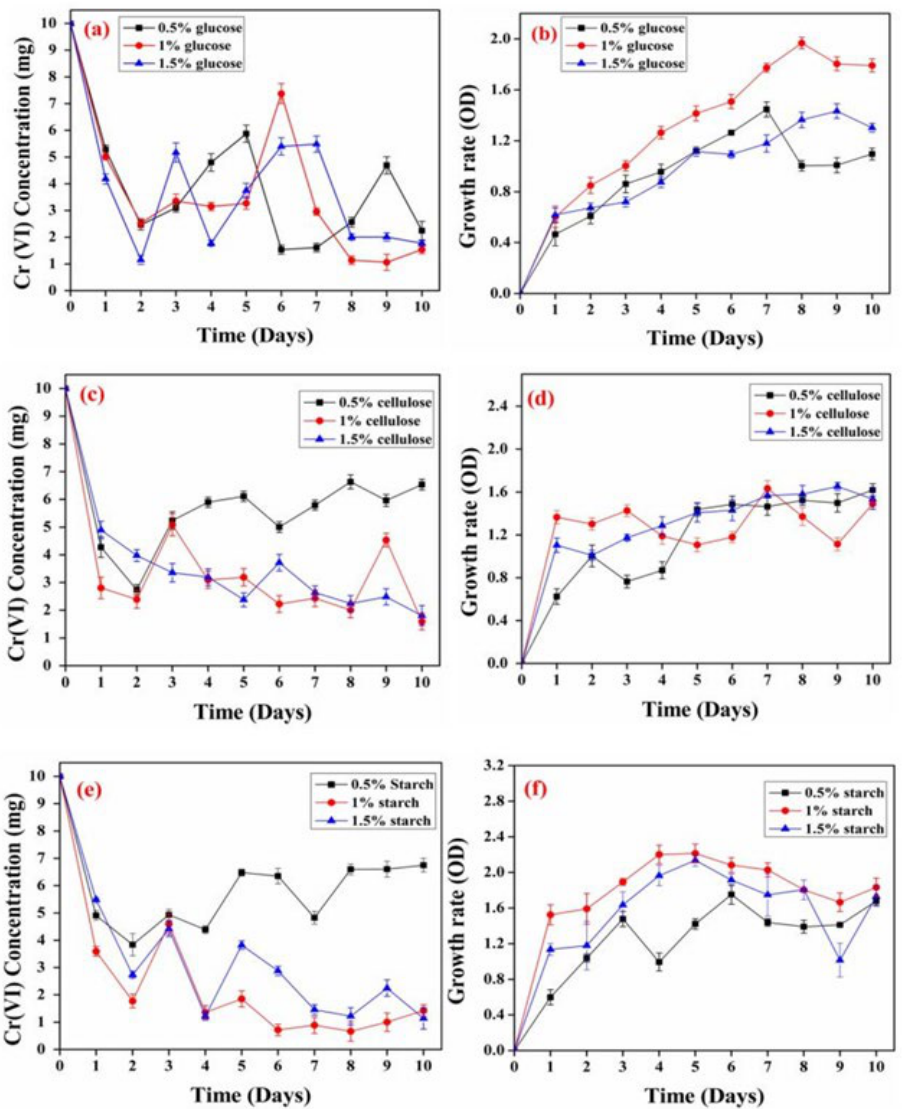
Fig. 4. Influence of various carbon sources on the reduction of hexavalent